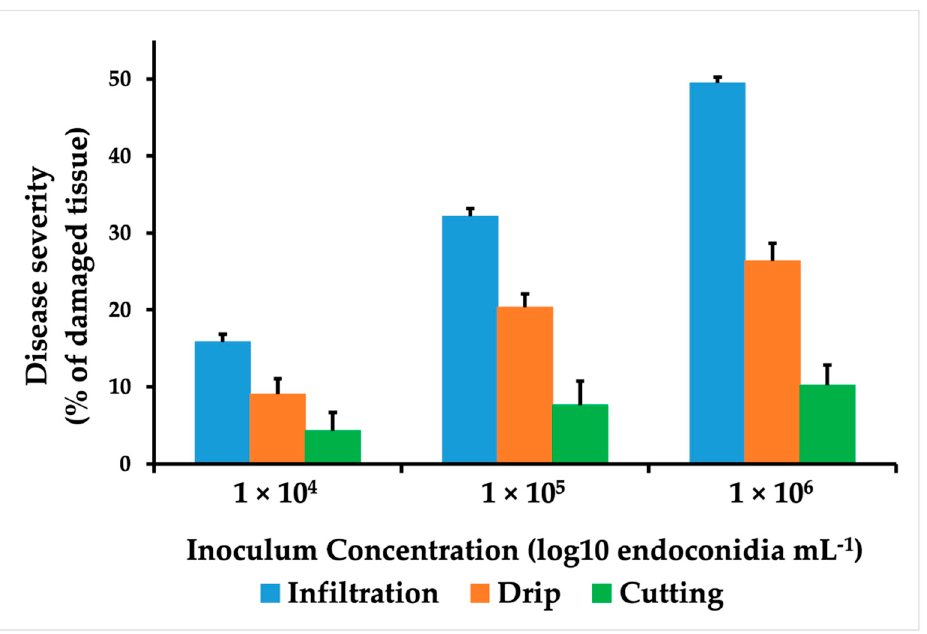
Figure 2. Inoculation method comparison . E. guineesis disease severity in seedlings inoculated with different concentrations of T. paradoxa spores (1 × 10 4 , 1 × 10 5, and 1 × 10 6 endoconidia per milliliter). The methods used were infiltration (blue), cutting with scissors (green), and drip (orange). Values correspond to the means of nine replications at 240 hpi. Error bars correspond to mean standard